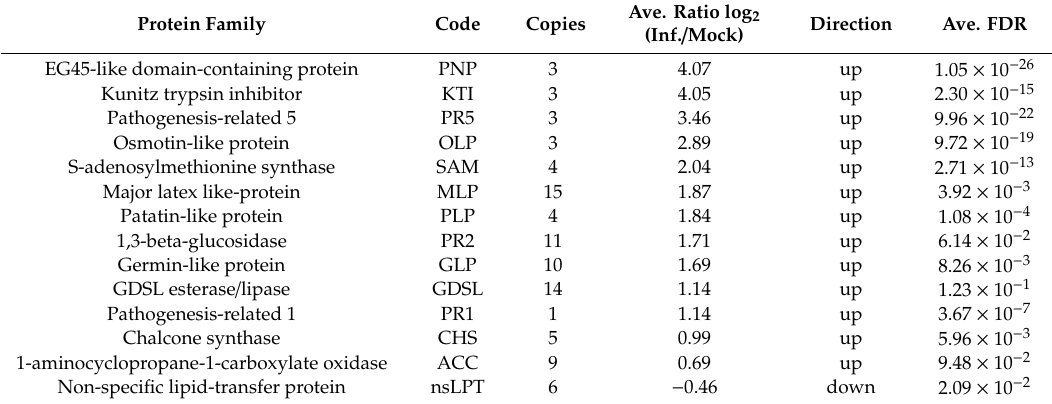
Table 2. J. regia proteins associated with the defense response (complete table in the Supplemental Materials, Table S10).